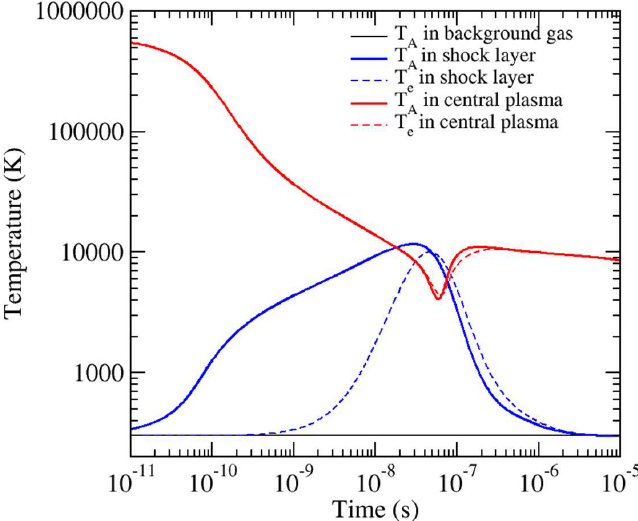
Figure 9. Same as Figure 7, but for the temperatures.